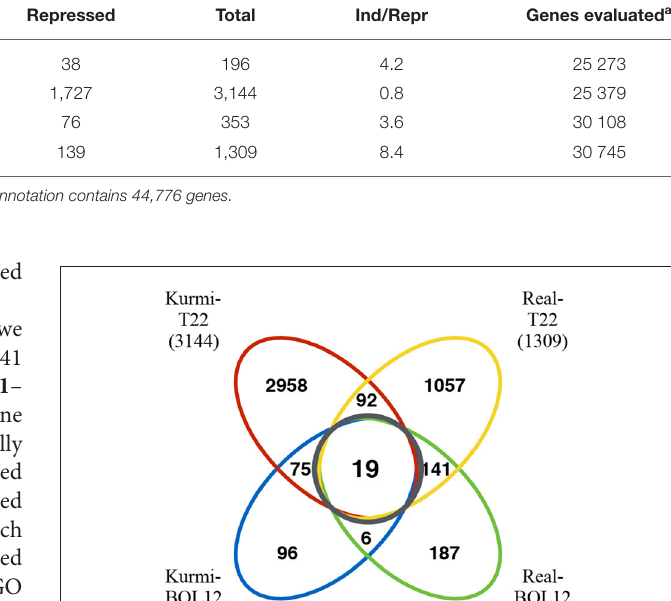
TABLE 2 | Differentially expressed genes in quinoa roots treated with Trichoderma . Quinoa